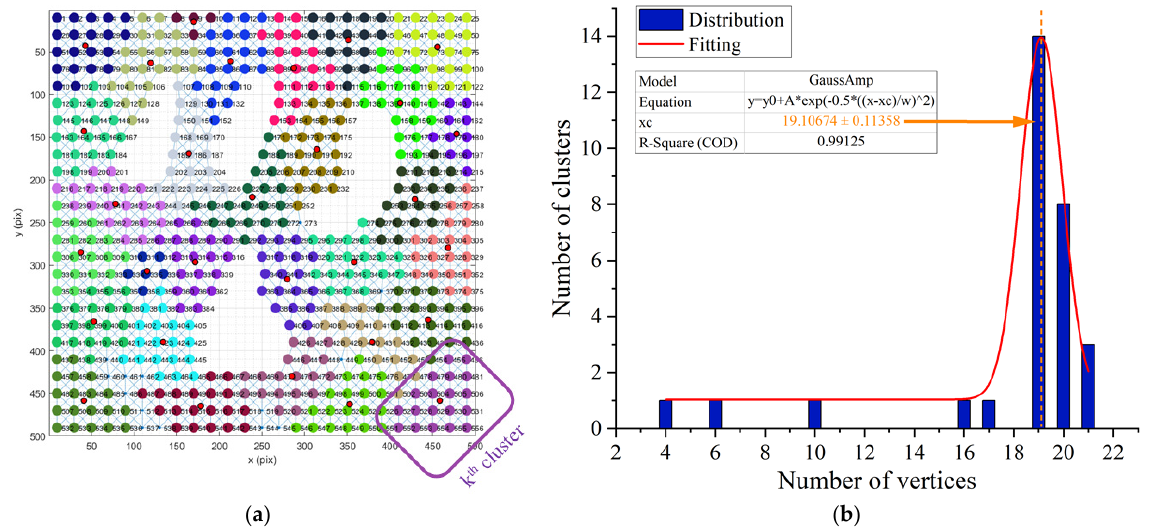
Figure 5. ( a ) The clustering of the vertices V 1 of the terrain graph G 1 . The colors stand for the clusters g k , red points are the “centers of mass” of each cluster g k . ( b ) The distribution of the clusters g k by number of vertices | v k | . This indicates that the average number of vertices in clusters g k is close to the selected limiting number 𝑁 = 21 .